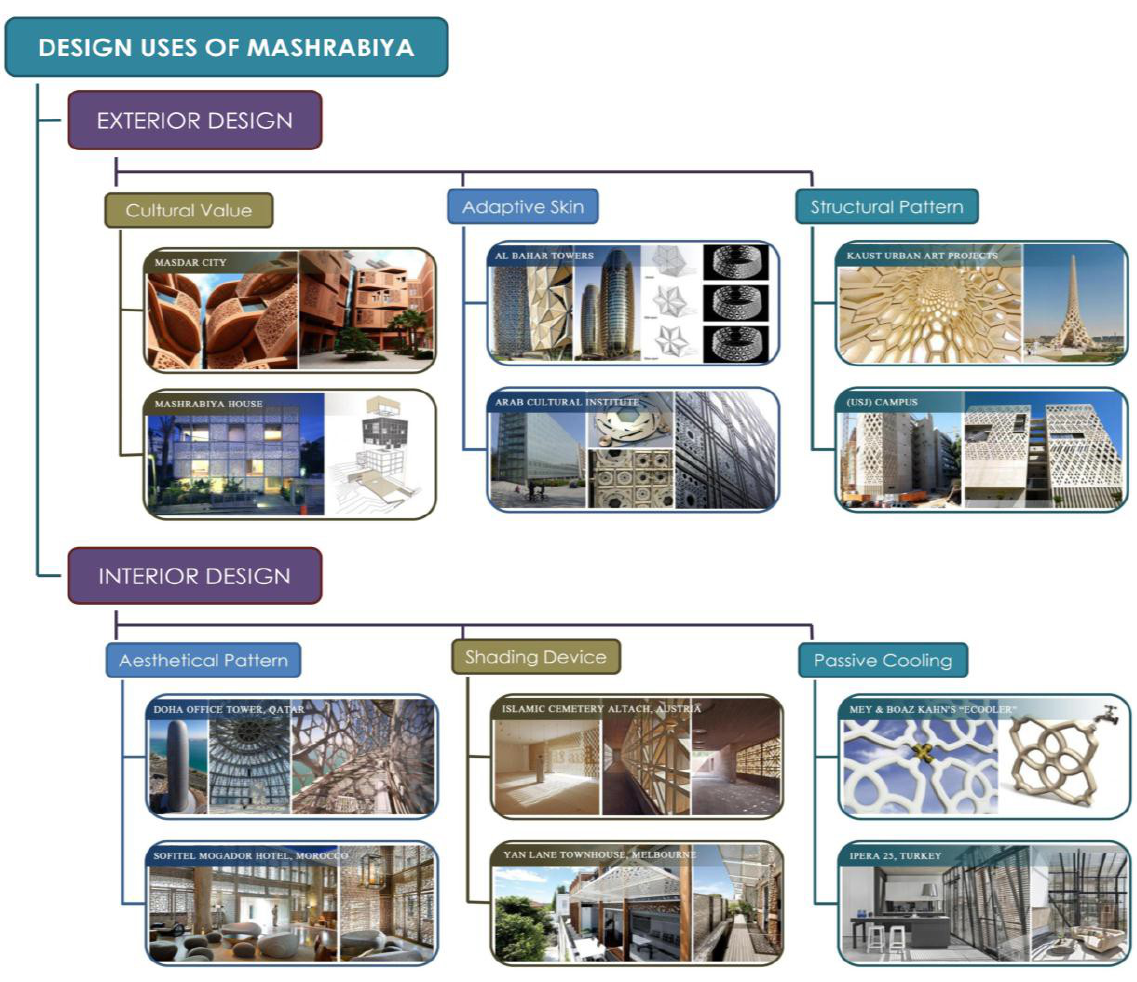
Figure 4. Mashrabiya context within exterior and interior design, Source: